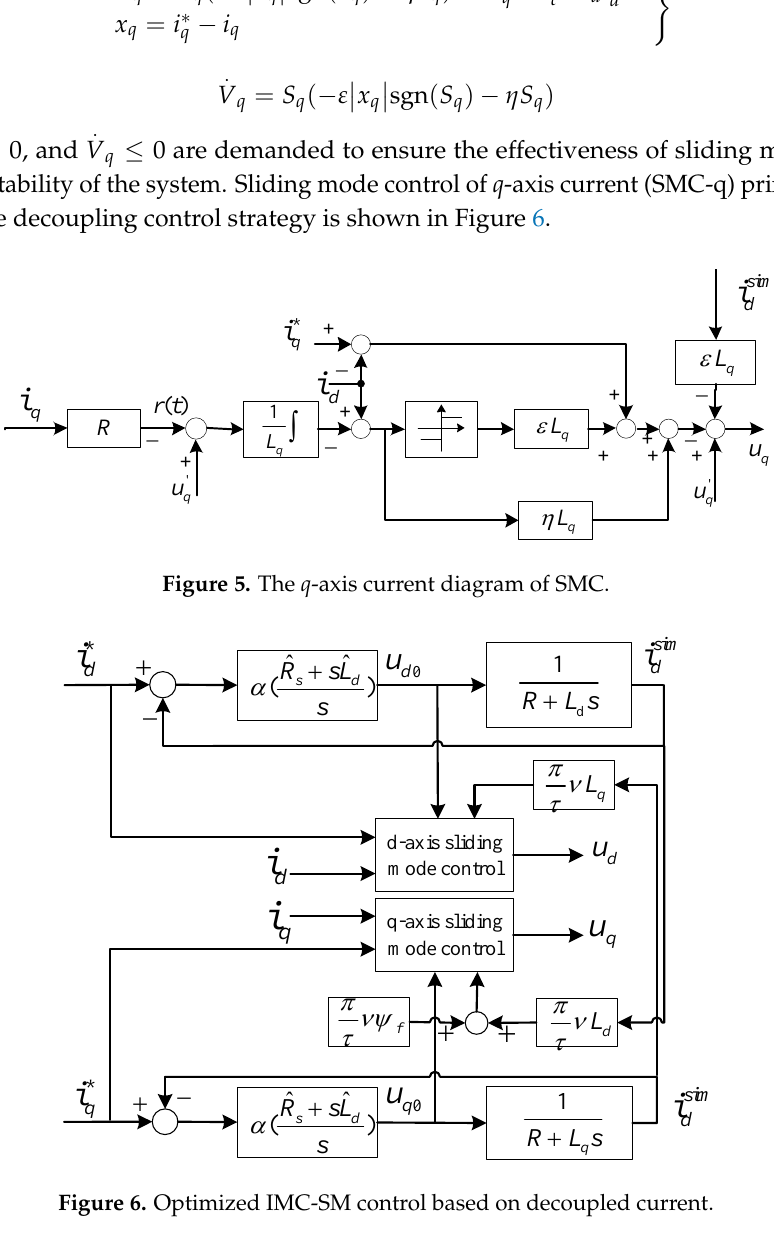
Table 1. Basic parameters of free-piston Stirling power generating system. Name